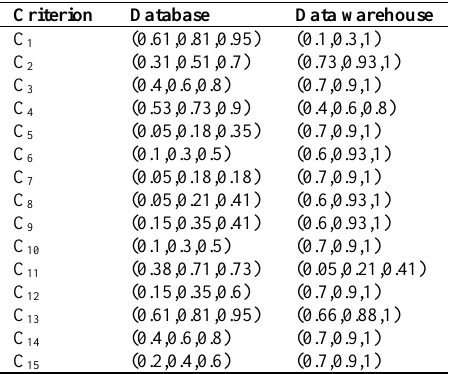
Table 12. Average comments of six